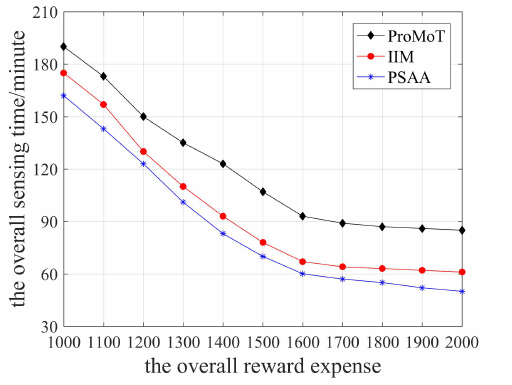
Figure 9. The overall sensing